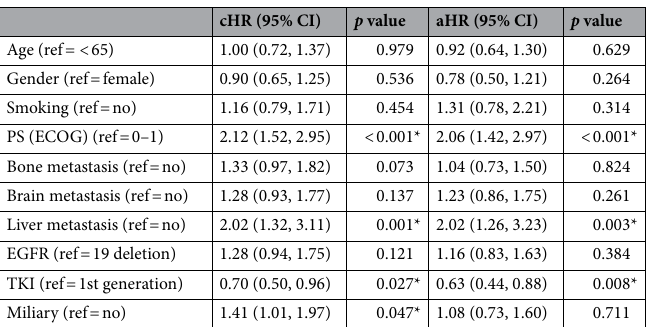
Table 2. Associations between miliary and